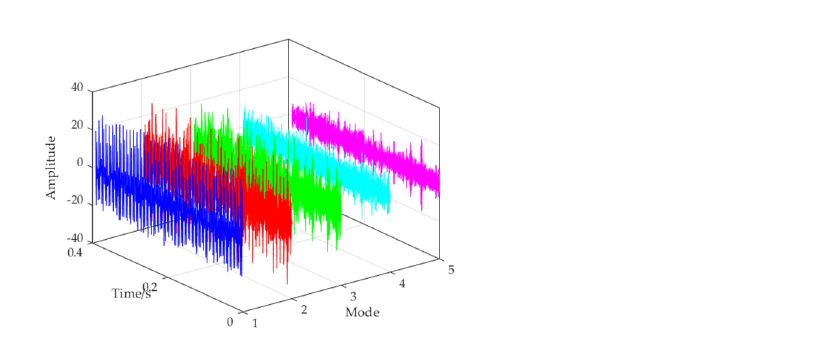
Figure 16. Composite fault signal. ( a ) Time-domain waveform. ( b ) Envelope spectrum.